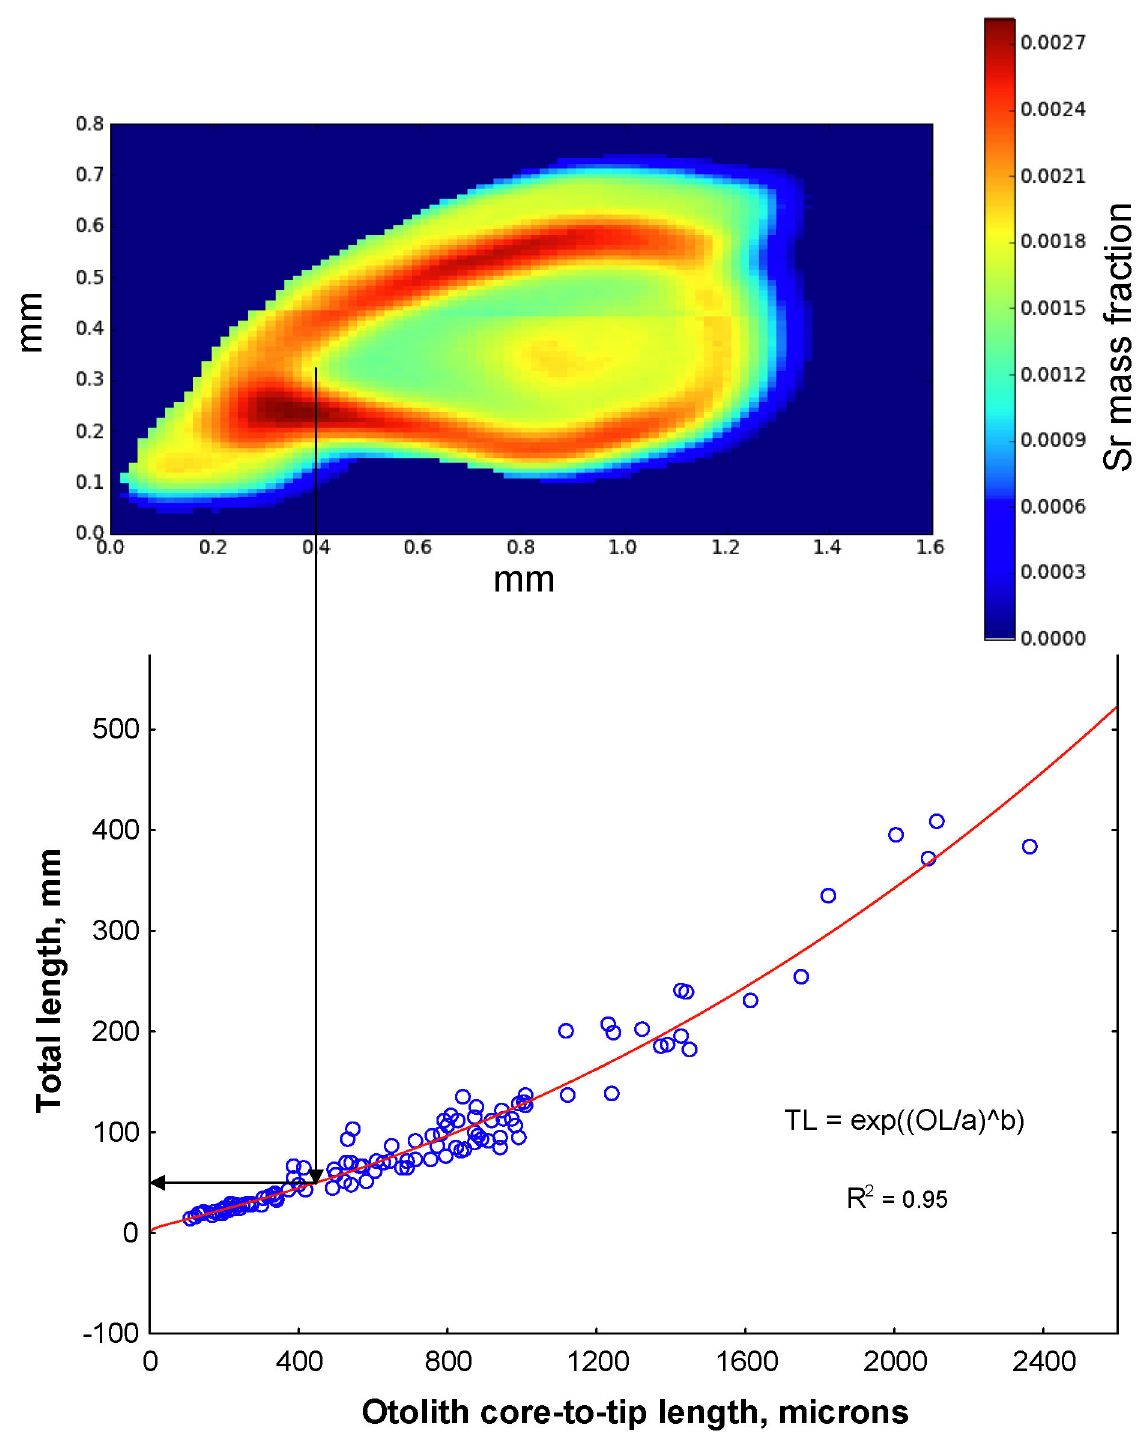
Figure 3. Illustration of back-calculation of size at first egress. Top figure is a strontium map of a humpback chub otolith; below it is the total length-otolith length nonlinear fit. The distance on the longest growth axis (anterior) to a migration event (elevated SrSr) is measured; the corresponding total length is computed using Equation 1.